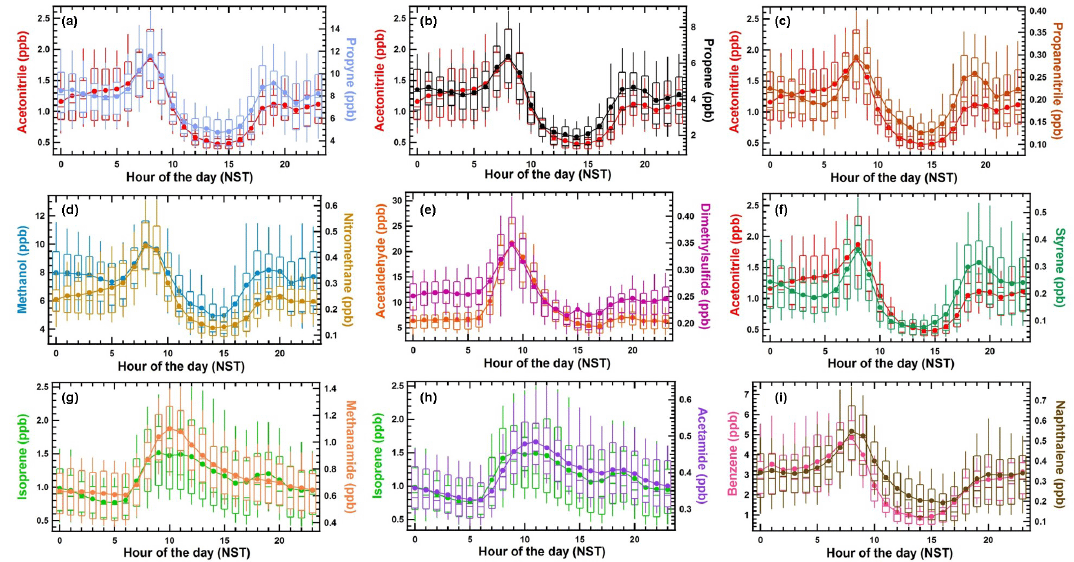
Figure 7. Comparison of diel box and whisker profiles of several rarely measured or previously unreported ambient VOCs with more frequently measured VOCs/emission